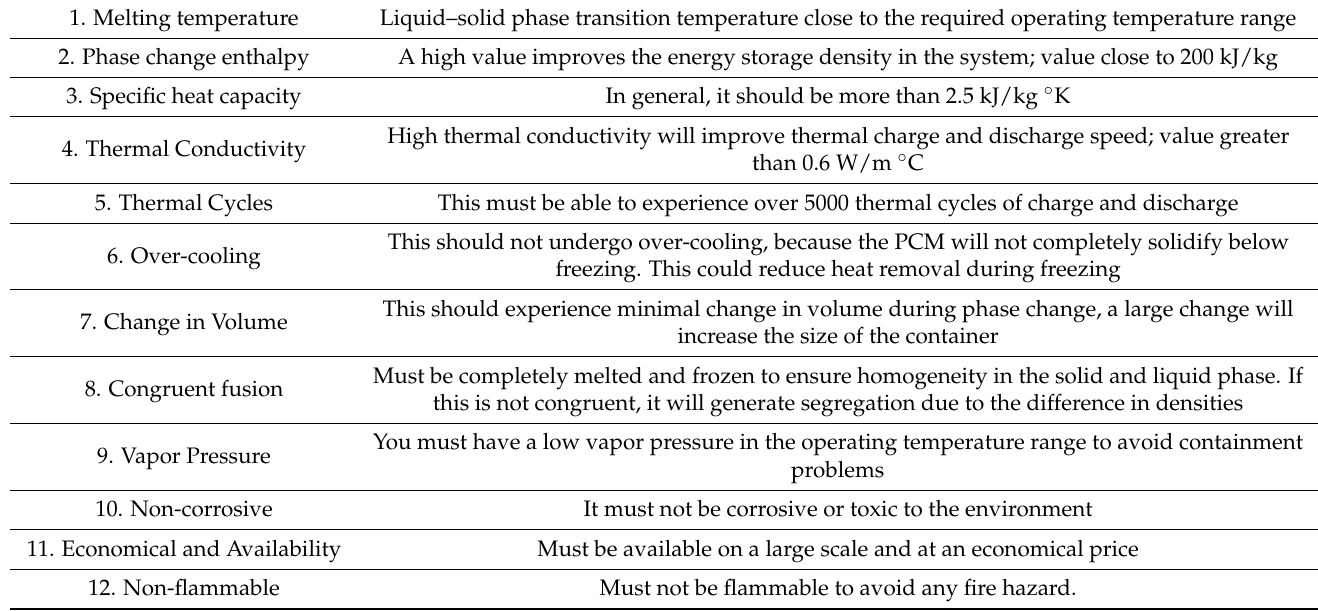
Table 1. Characteristics of macro-encapsulated PCMs for